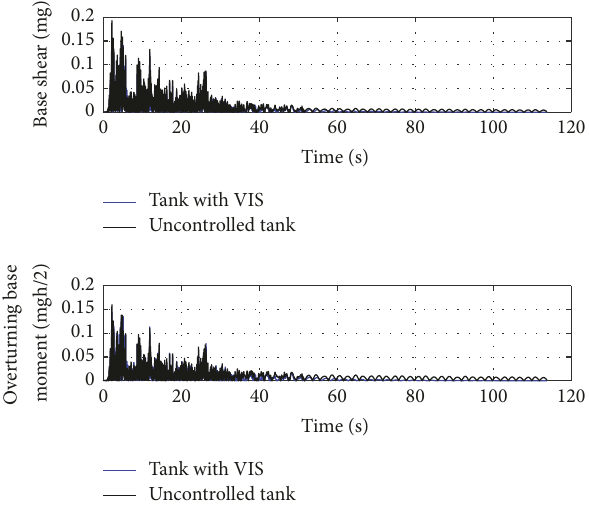
Figure 15: Base shears and overturning base moments of the tank with the VIS and the uncontrolled tank under the excitation of the El Centro earthquake.